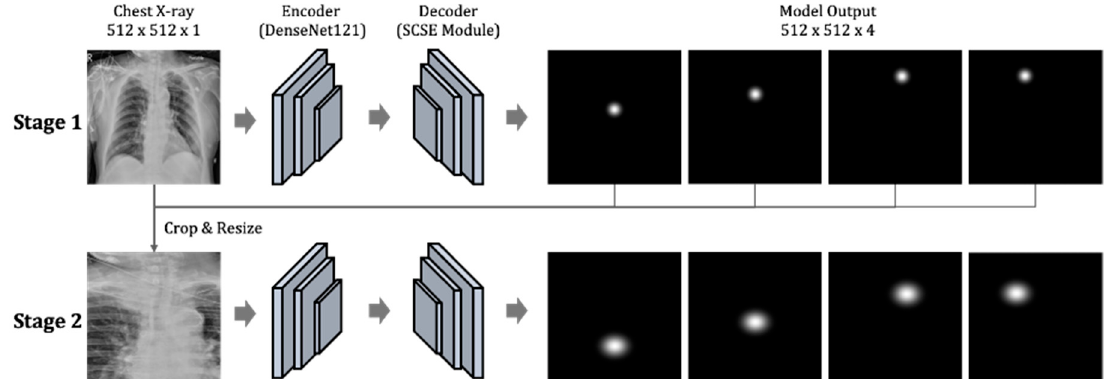
Figure 2. The two-stage key point detection model.